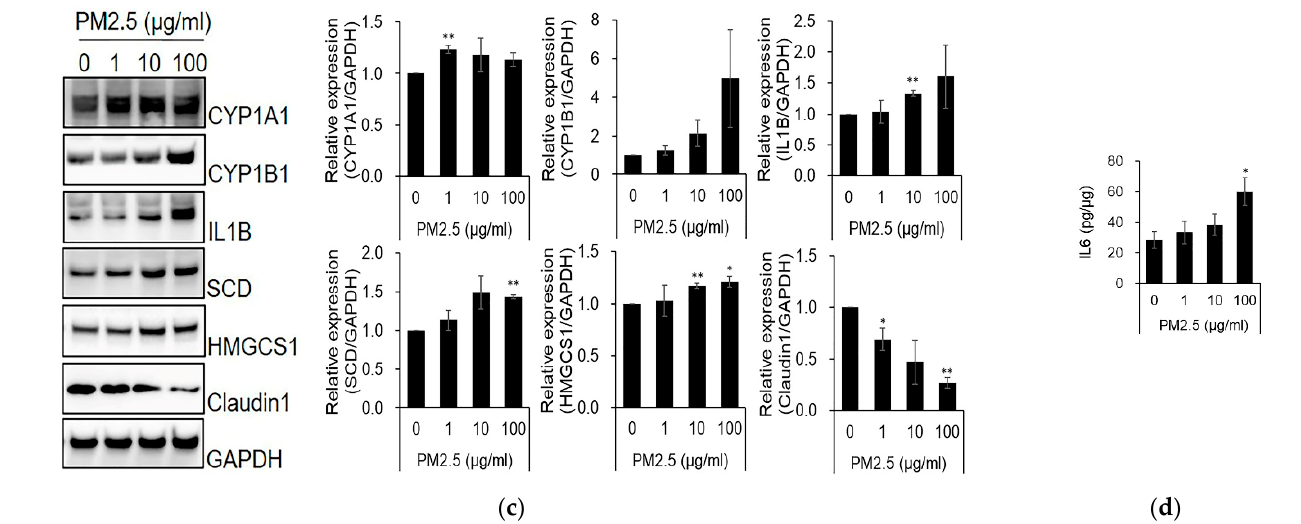
Figure 1. PM 2.5 alters the expression of xenobiotic metabolism, inflammatory response, oxidative stress, lipid metabolism, and cell barrier-related factors. Transcriptome analysis with RNA-seq was performed using SZ95 sebocytes treated with PM 2.5 (100 μ g/mL) and a control group. The top 20 most prevalent KEGG terms ( a ) were obtained from pathway enrichment analysis of differentially expressed genes (DEGs; |fold changes| > 2, p -value < 0.05) in SZ95 sebocytes with PM 2.5 treatments. Bars represent − log10 ( p -value). p -values were calculated by modified Fisher’s exact tests. ( b ) RT- qPCR was performed to analyze the mRNA expression of DEGs. ( c ) The expression levels were analyzed by SDS-PAGE and immunoblotting for the indicated antibodies. The relative expression levels of proteins were quantified using the Image J program. ( d ) IL6 secretion was analyzed by ELISA and normalized to the total protein. Data were analyzed by Student’s t -test (* p < 0.05, ** p < 0.01, *** p < 0.001 vs. untreated control; n = 3). Table 1. Top canonical pathways of DEGs identified by Ingenuity Pathway Analysis (IPA). Top canonical pathways were analyzed using DEGs (|fold changes| > 1.5, p -value < 0.01). Z-score indicates the predicted activation (positive value) or inhibition (negative value) of the canonical pathway. Ratio is calculated by dividing the number of the DEGs in a pathway by the total number of genes that make up the pathway. Molecules are genes in the DEGs that are related to the pathway. p -values were calculated by right-tailed Fisher’s exact